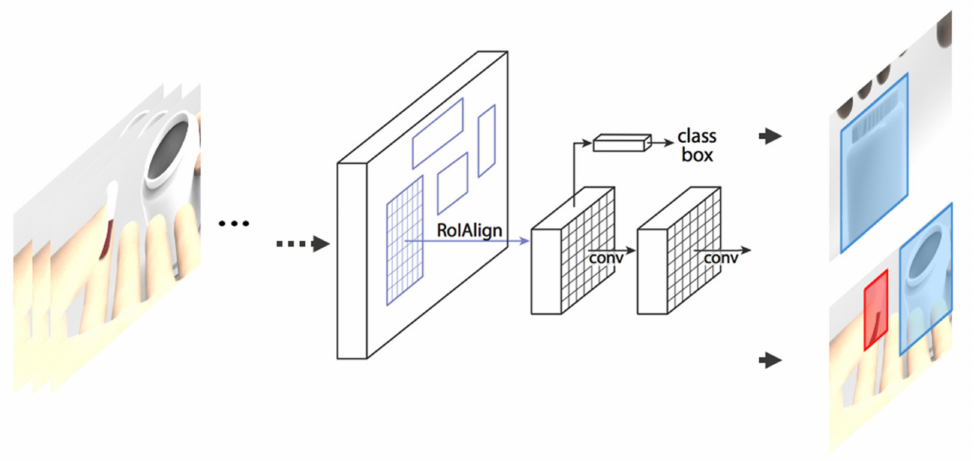
Figure 7. R-CNN classification model for object